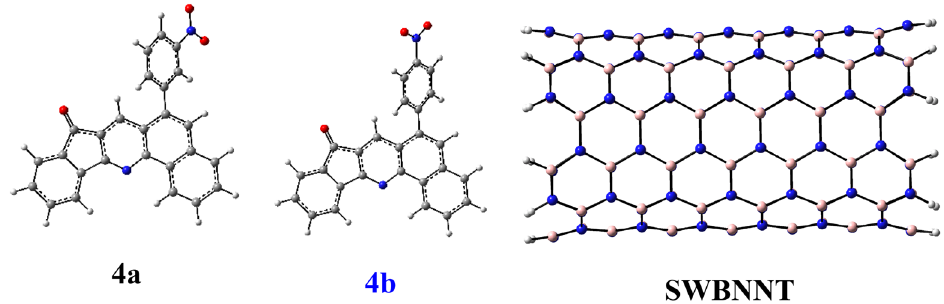
Figure 1. Ground state structure of the 4a, 4b, and single walled boron nitride nanotube (SWBNNT) in ωB97- XD/6-31g* level of theory.